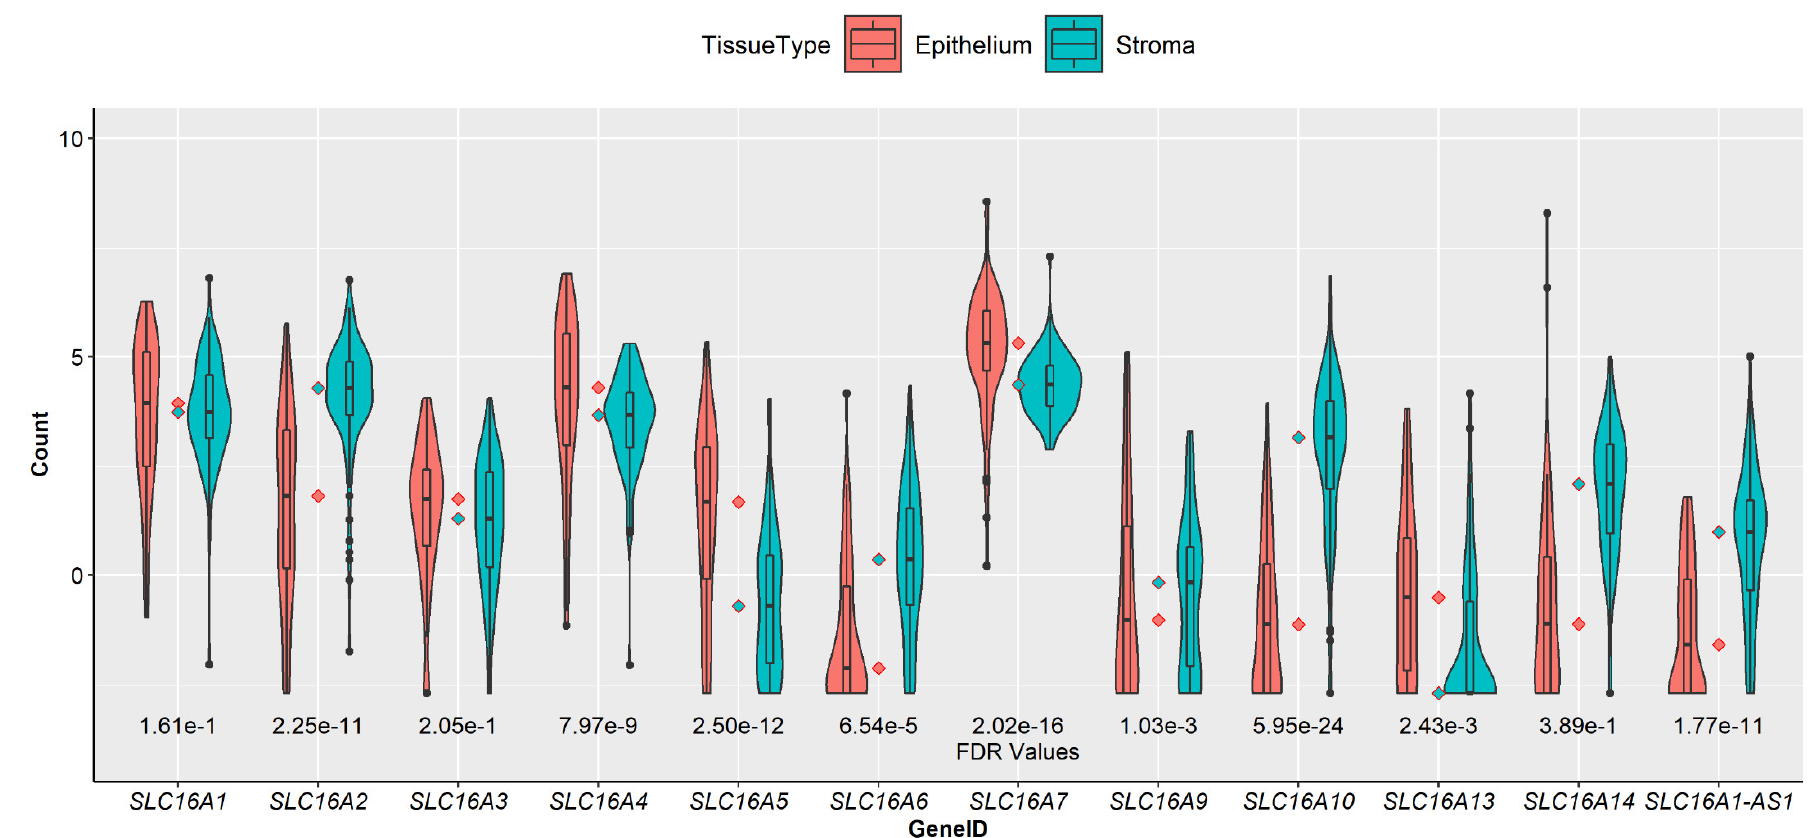
Figure 2. Violin plots of log-normalised expression values of MCT genes in PDAC stroma ( n = 123) and the epithelium ( n = 66). FDR indicates a false discovery rate of 5%. Four MCT genes showed significant upregulation in the stroma ( SLC16A2/6/10 and SLC16A1-AS1 ), with 5 MCTs being significantly upregulated in the epithelium ( SLC4/5/7/9/13 ) and 3 showing no difference in expression between the two tissues. SLC16A4 and SLC16A10 showed the largest upregulation in the epithelium and stroma, respectively.